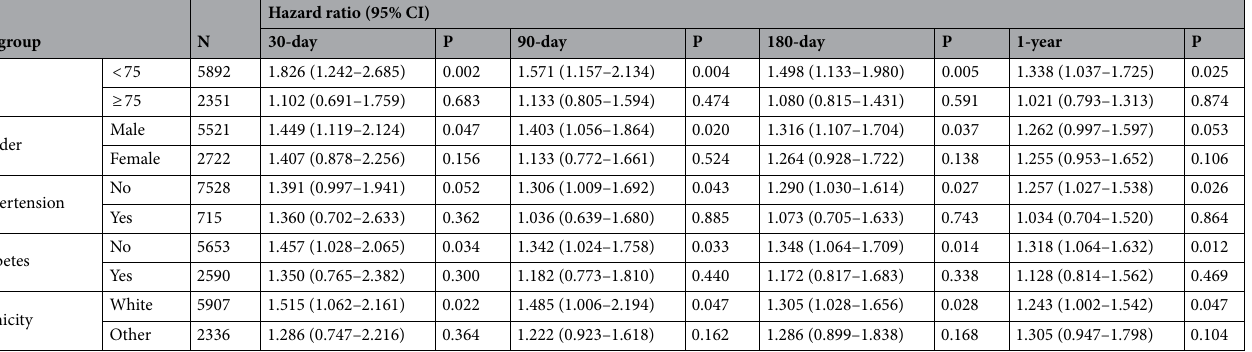
Table 3. Association between MHR group and 30-day, 90-day, 180-day and 1-year mortality of patients with cardiac surgery in different subgroups. Hazard ratios of 30-day, 90-day, 180-day and 1-year mortality risk on the stratification of age levels, gender, hypertension, diabetes and ethnicity. Patients in high MHR group acts as the reference group. Adjusted variables included gender, age, ethnicity, SBP, DBP, SOFA, hypertension, CKD, COPD, diabetes. CI confidence interval, SOFA sequential organ failure assessment, SBP systolic blood pressure, DBP diastolic blood pressure, CKD chronic kidney disease, COPD chronic obstructive pulmonary